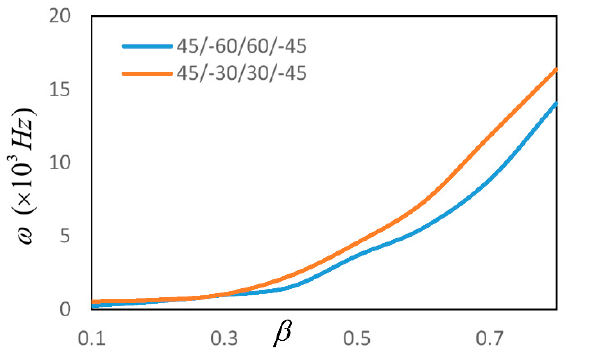
Figure 7. The relation of radii ratio and fundamental angular frequency parameter of four-layered annular circular plates with ply orientation 45 ◦ / − 30 ◦ /30 ◦ /45 ◦ ( AGE / EGE / EGE / AGE ) .